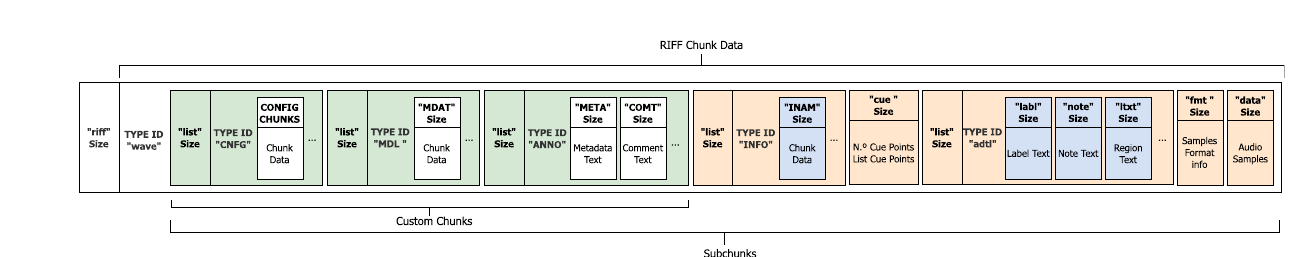
Figure 2. Chunk structure of the EMD-DF 64 file format.